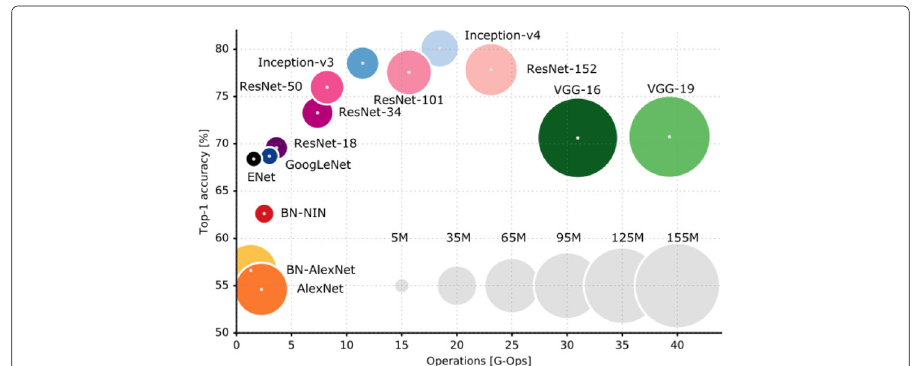
Fig. 2 Top 1 one-crop accuracy (using only the center crop ) on the ImageNet-1k validation set with respect to the computational complexity of the model. The computational complexity is measured as the number of floating-point operations (FLOPs) required for a single forward pass. The size of each ball corresponds to the number of learnable parameters 5 error of 4.49%. An ensemble of ResNets which achieves 3.57% top 5 error won the ILSVRC-15.